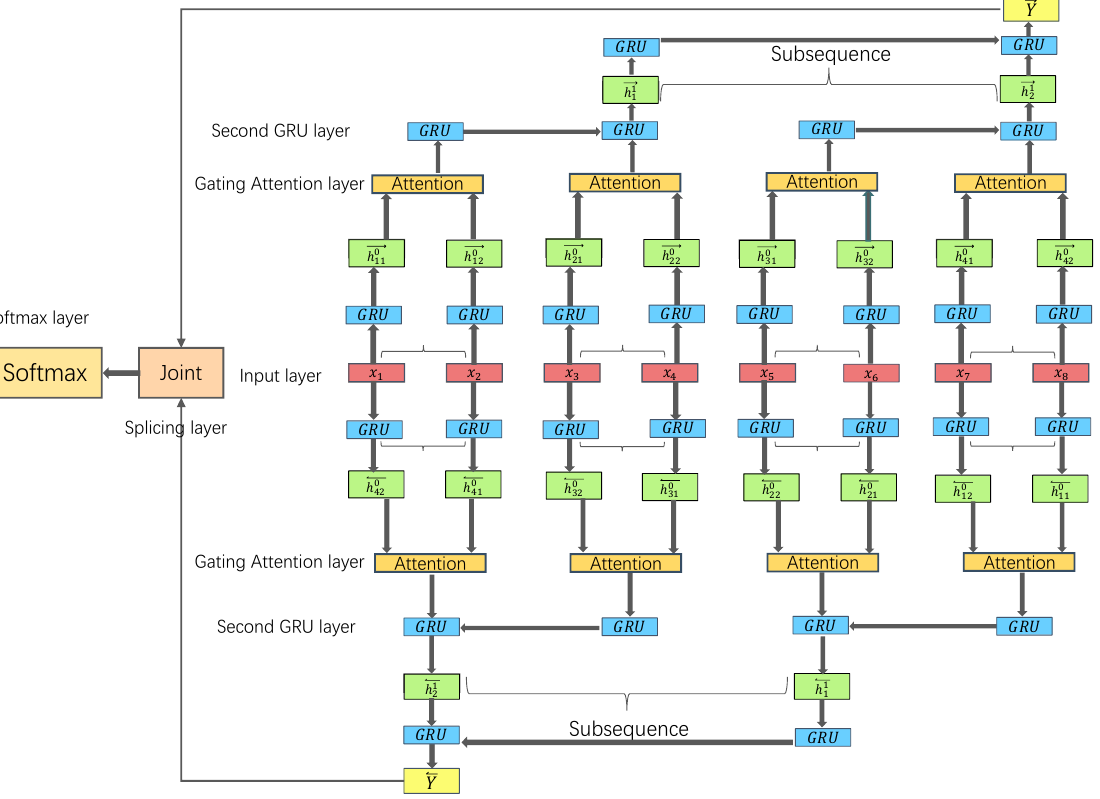
Figure 4. Log anomaly detection BiSGRU-GA.